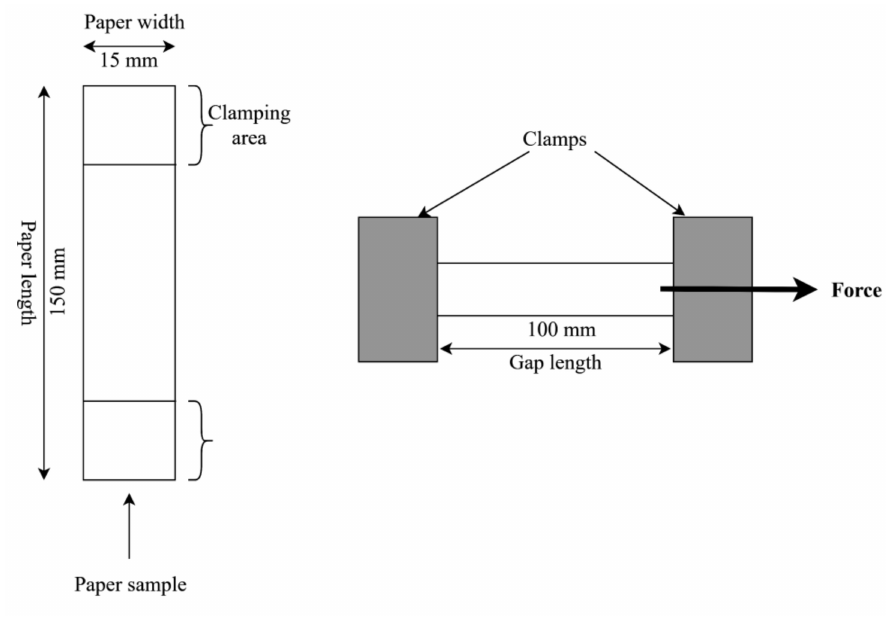
Figure 11. Tensile strength measurement.